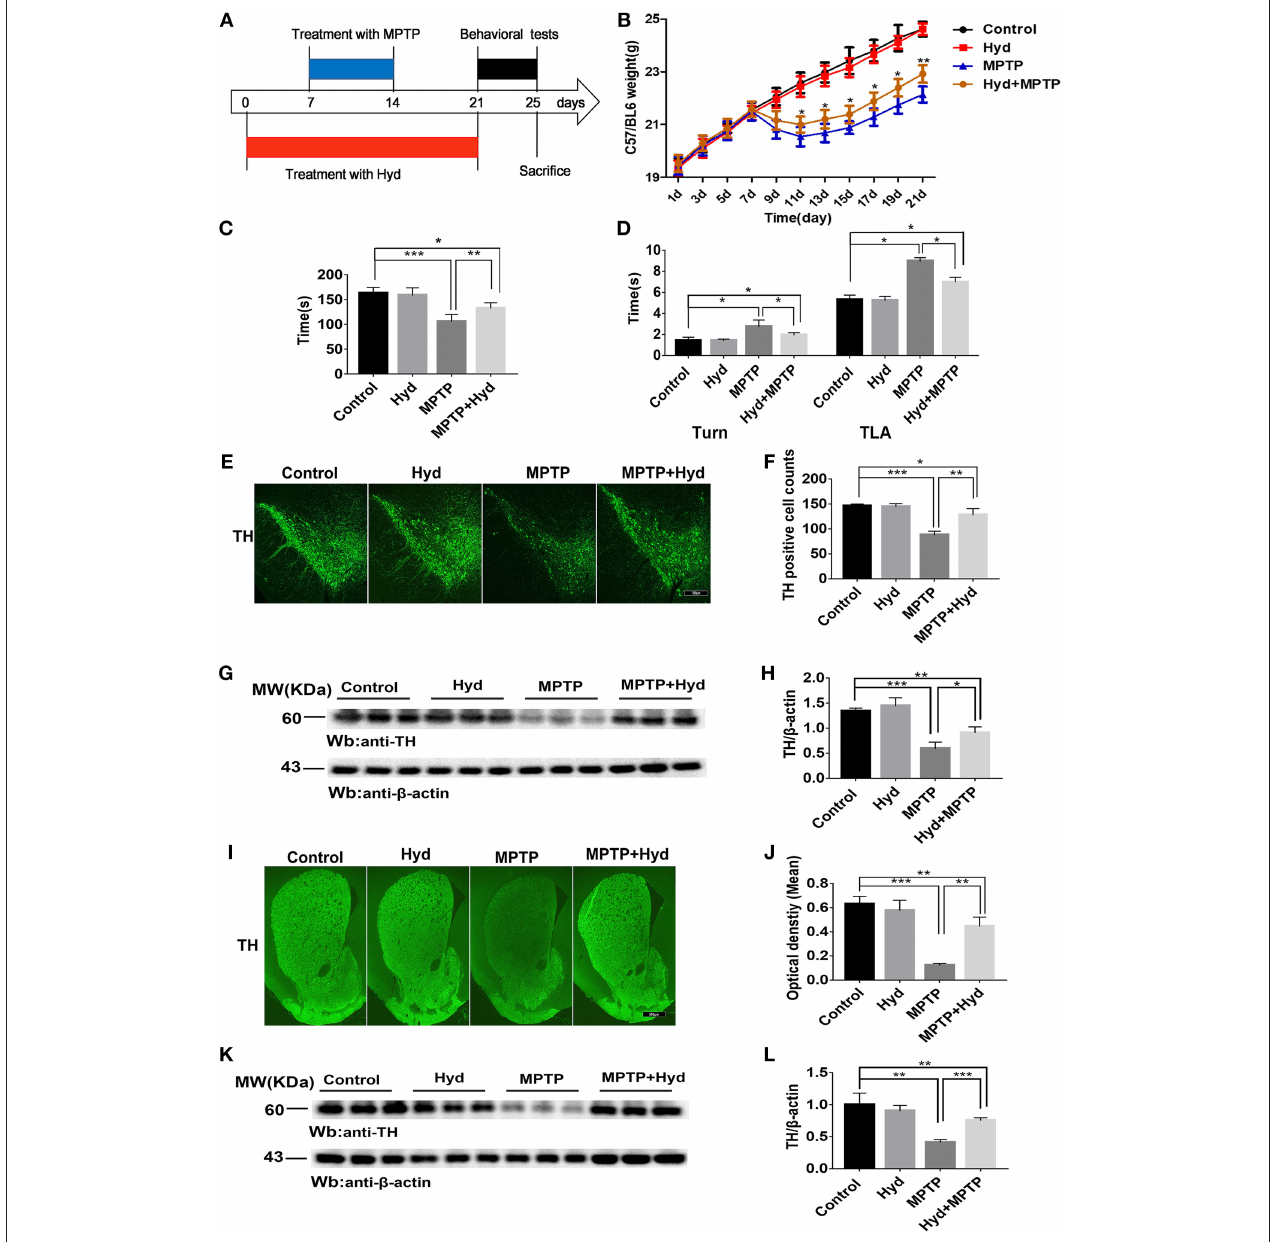
FIGURE 3 | Hydralazine confers protection in dopaminergic neurons in the MPTP model of Parkinson’s disease. Schematic representation of the MPTP model experimental design (A ). Hydralazine alleviated MPTP-induced weight loss (B) . * p < 0.05, significant difference between the two indicated groups ( n = 8). Hydralazine ameliorated MPTP-induced behavior disorder (C,D) . Performance on the rotarod and pole test was impaired in MPTP-treated group. However, impairment was ameliorated in MPTP model treated with hydralazine. * p < 0.05, ** p < 0.01, *** p < 0.001, significant difference between the two indicated groups ( n = 8). Tyrosine hydroxylase immunofluorescence of substantia nigra pars compacta (SNpc). Scale bar = 250 µ m. We found that there were fewer TH positive neurons in the similar anatomic level sections of SN in the MPTP mice than hydralazine- treated mice, MPTP mice with hydralazine and control mice, compared to the MPTP mice group, MPTP mice with hydralazine group significantly attenuated the loss of dopaminergic neurons in SNpc (E,F) . * p < 0.05, ** p < 0.01, *** p < 0.001, n = 6, very significant difference between the two indicated groups. The western blotting of TH in SN further reconfirmed the findings (G and H). * p < 0.05, *** p < 0.001 n = 6, significant difference between the two indicated groups. The MPTP neurotoxicity also resulted the decrease of the TH positive DA terminals in the striatal region of the MPTP mice group compared with MPTP mice with hydralazine group. (I,J) . Scale bar = 500 µ m. ** p < 0.01, *** p < 0.001, n = 6, very significant difference between the two indicated groups. Immunoblotting also validated this observation (K,L) . ** p < 0.01, *** p < 0.001, n = 6, compared with the two indicated groups. Data were presented as mean ± SEM.